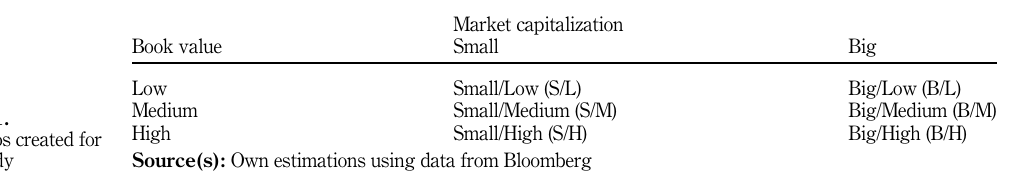
Table 1. Portfolios created for this